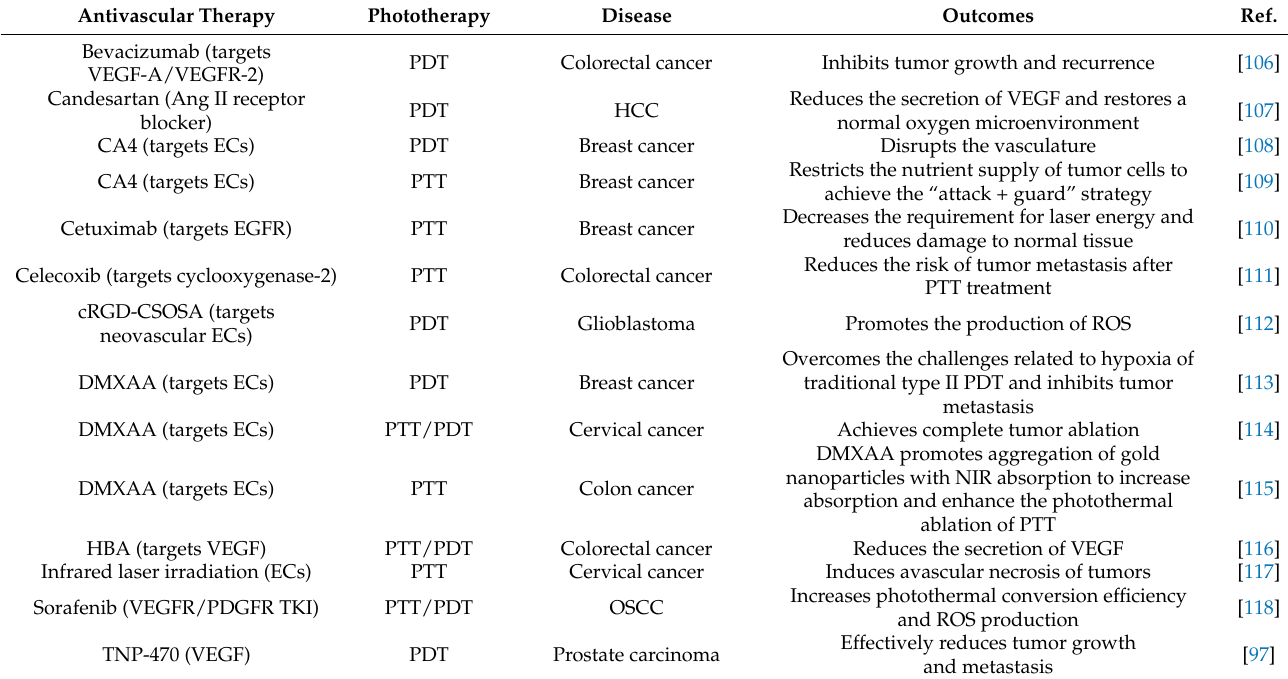
Table 3. Combined therapeutic paradigms of antivascular therapy and